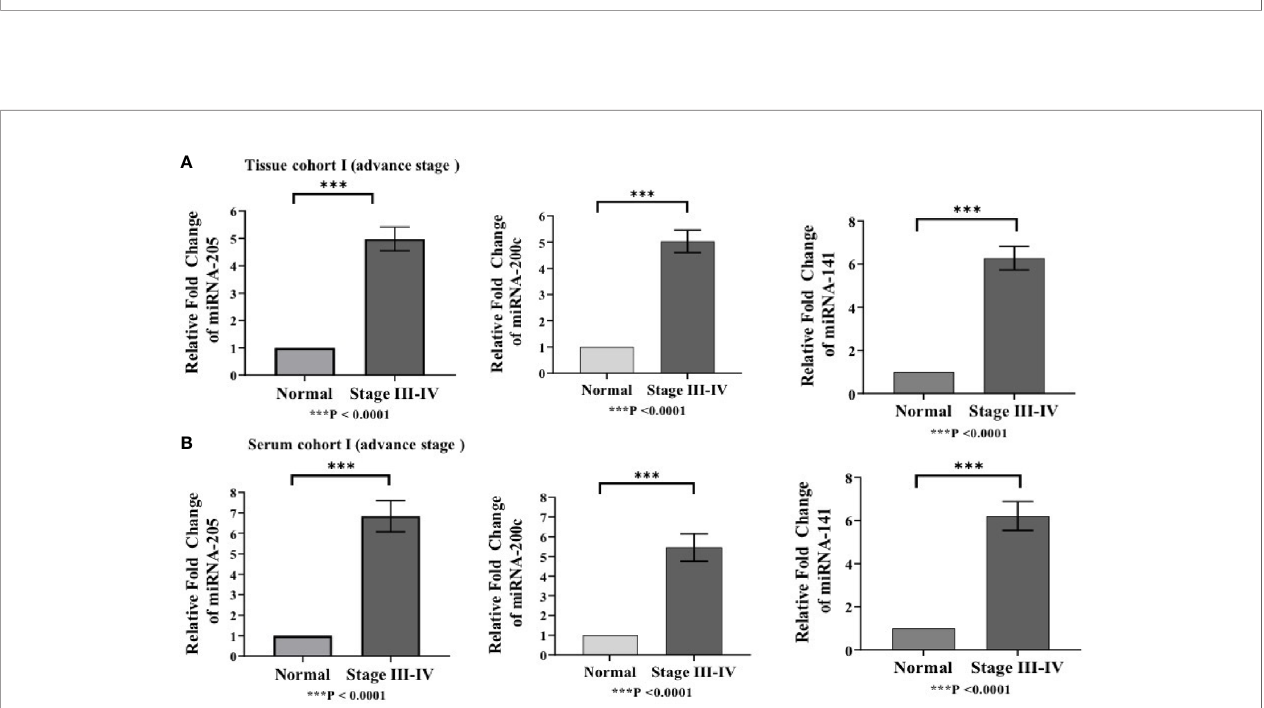
FIGURE 3 | Represents upregulation of miRNAs in epithelial ovarian cancer in cohort I of tissue and serum both. (A) In tissue cohort-I {n=74 (EOC=44, Normal=30)}, expression levels of miR-205, -200c, and miR-141 were increased in the cancer group by 4.98(P < 0.0001), 5.03 (P < 0.0001), and 6.27 (P <0.0001) fold respectively when compared with the control group. (B) In serum cohort-I{n=45 (EOC=30, Normal=15)}, the fold change of miR-205, miR-200c and miR-141 was 6.83 (P <0.0001); 5.46(P<0.0001) and 6.21 (P<0.0001) respectively. Statistically signi fi cant differences were determined by the Mann Whitney U-tests. Data represent mean ± standard error on the mean (SEM). ***P < 0.0001.